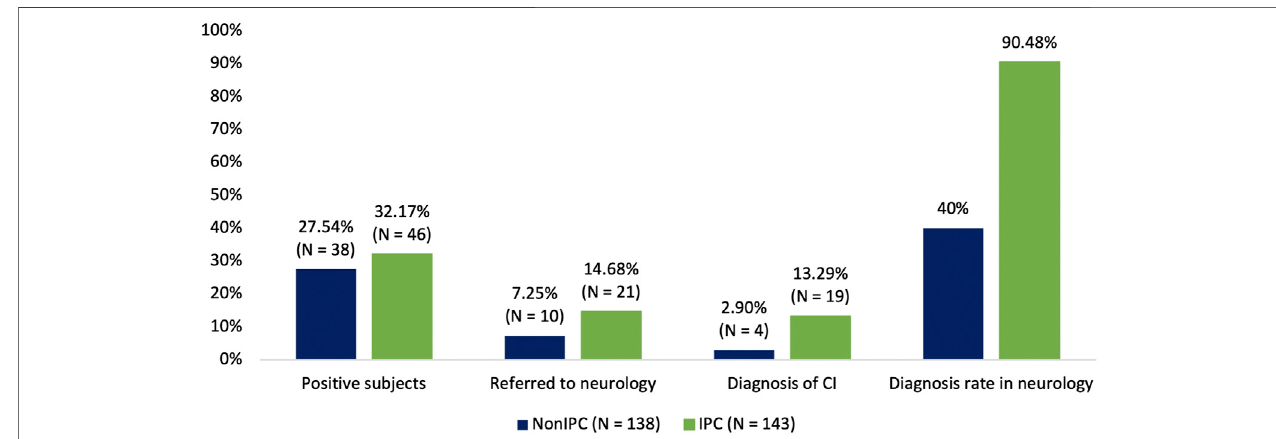
FIGURE3| DifferencesbetweenNonIPCgroupandIPCgroupregardingthepercentageofpositivesubjects,thepercentageofsubjectsreferredtoneurology,and the percentage of subjects diagnosed with CI. The last diagram bar represents the diagnosis rate in neurology in both groups concerning the overall referred subjects.